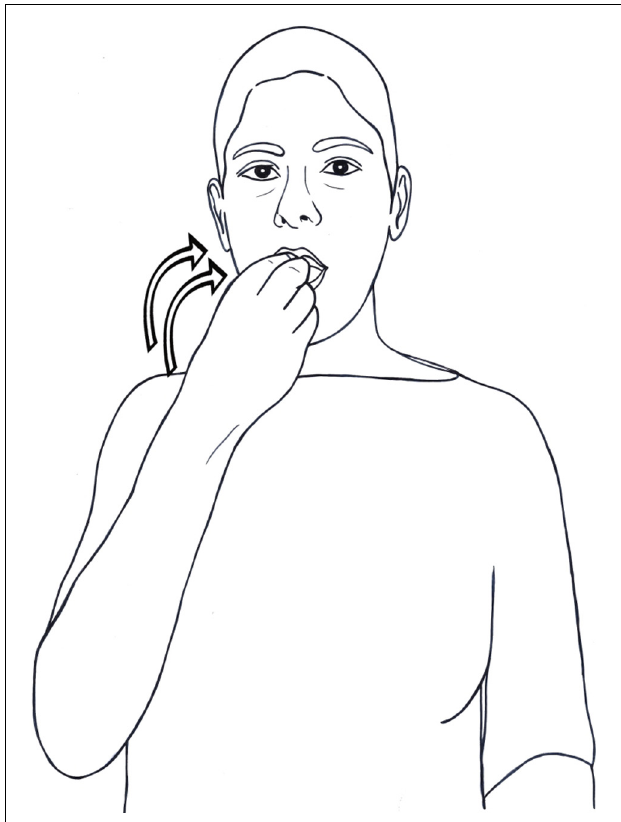
FIGURE 1 | An iconic sign: EAT (ISL).